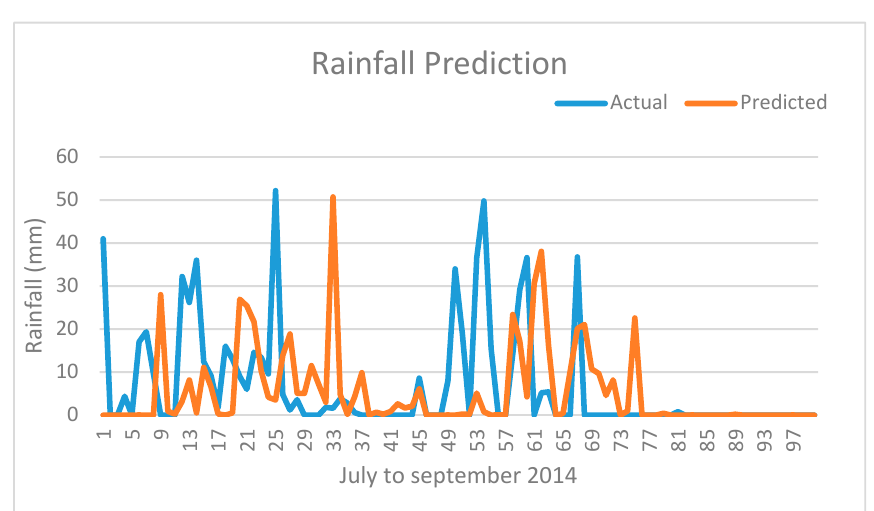
Figure 12. Comparison of actual and predicted rainfall.